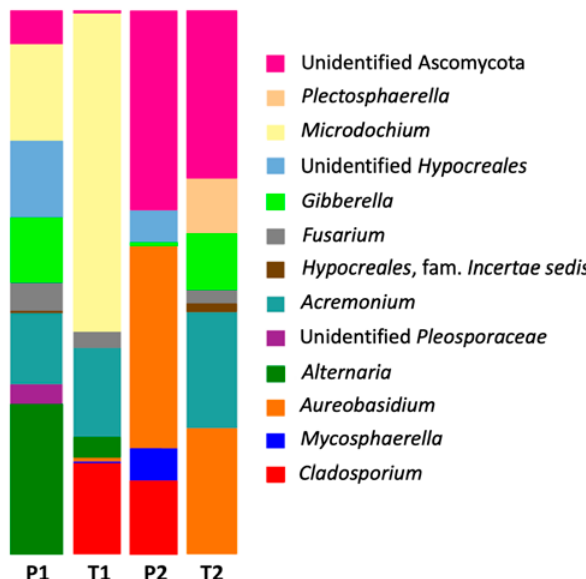
Figure 1. Taxonomic composition of cultured endophytic fungi. Genera distributions of endophytic fungi grown in cultures and analyzed using HTS, among four wheat variety and field categories: P1 = Perciasacchi from Field 1; T1 = Tumminia from Field 1; P2 = Perciasacchi from Field 2; and T2 = Tumminia from /Field